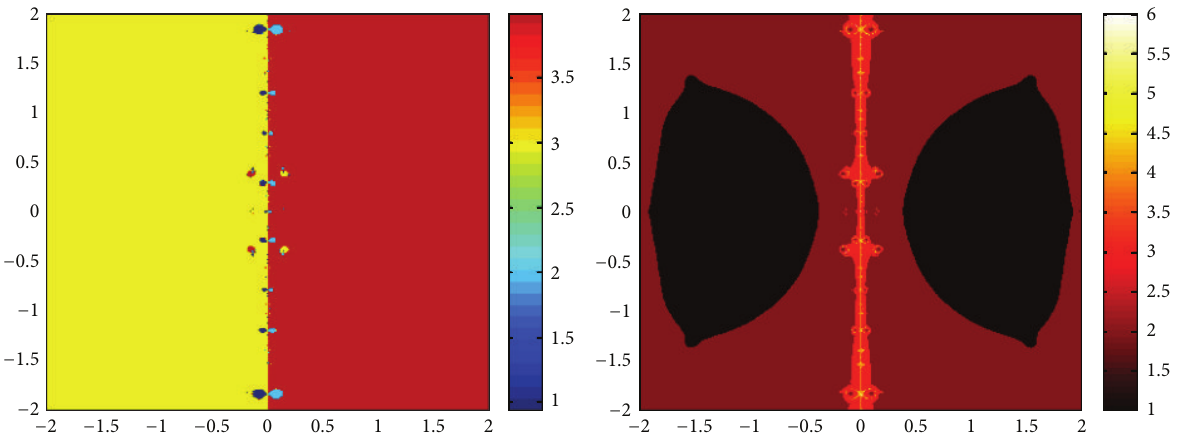
Figure 5: Basins of attraction of method (9) for 𝑝 4 (𝑥)